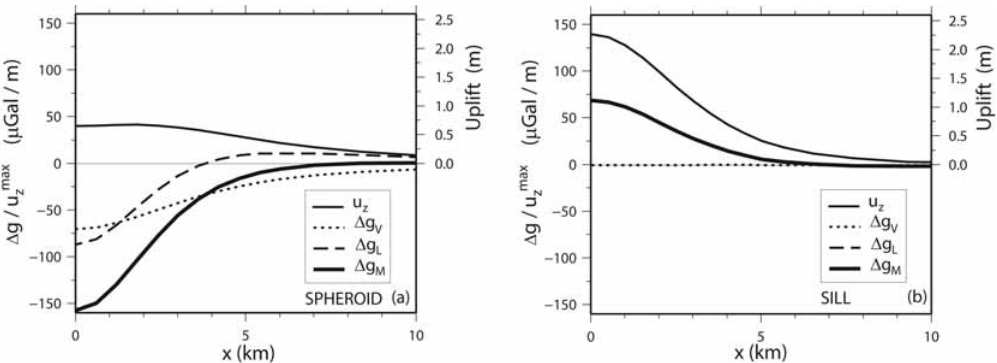
Fig. 7a,b. Gravity terms normalized to the maximum uplift u z max , and vertical displacement in a homogeneous medium due to (a) vertically elongated spheroidal source, (b) horizontal sill (in this case ∆ g V 0 and ∆ g M over- laps ∆ g L ).